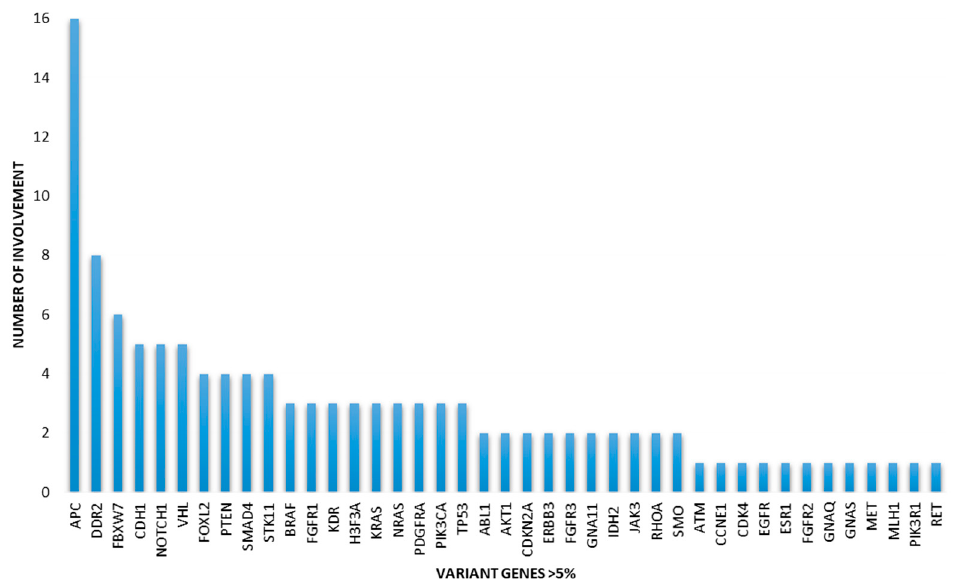
Figure 1. The spectrum and frequency of pathogenic gene variants identified in synchronous thyroid carcinomas associated with Hashimoto’s thyroiditis. ( APC : adenomatous polyposis coli; DDR2 : discoidin domain receptor tyrosine kinase 2; FBXW7 : F-box / WD repeat-containing protein 7; CDH1 : cadherin 1; NOTCH1 : Notch homolog 1, translocation associated; VHL : von Hippel-Lindau tumor suppressor; FOXL2 : forkhead box protein L2; PTEN : phosphatase and tensin homolog; SMAD4 : SMAD family member 4; STK11 : serine / threonine kinase 11; BRAF : B-Raf proto-oncogene; FGFR1 : fibroblast growth factor receptor 1; KDR : kinase insert domain receptor; H3F3A : H3.3 histone A; KRAS : Kirsten Rat Sarcoma Viral Oncogene Homolog; NRAS : neuroblastoma RAS Viral Oncogene Homolog; PDGFRA : platelet-derived growth factor receptor alpha; PIK3CA : phosphatidylinositol-4,5-bisphosphate 3-kinase catalytic subunit alpha; TP53 : tumor protein p53; ABL1 : ABL proto-oncogene 1, nonreceptor tyrosine kinase; AKT1 : AKT serine / threonine kinase 1; CDKN2A : cyclin-dependent kinase inhibitor 2A; ERBB3 : erb-b2 receptor tyrosine kinase 3; FGFR3 : fibroblast growth factor receptor 3; GNA11 : G protein subunit alpha 11; IDH2 : isocitrate dehydrogenase 2; JAK3 : Janus kinase 3; RHOA : Ras Homolog Family Member A; SMO : Smoothened, Frizzled Class Receptor; ATM : Ataxia Telangiectasia Mutated; CCNE1 : Cyclin E1; CDK4 : Cyclin-Dependent Kinase 4; EGFR : endothelial growth factor receptor; ESR1 : Estrogen Receptor 1; FGFR2 : Fibroblast Growth Factor Receptor 2; GNAQ : G Protein Subunit Alpha Q; GNAS : G Protein Subunit Alpha S; MET : Hepatocyte Growth Factor Receptor; MLH1 : DNA Mismatch Repair Protein Mlh1; PIK3R1 : Phosphoinositide-3-Kinase Regulatory Subunit 1; RET : Proto-Oncogene Tyrosine-Protein Kinase Receptor